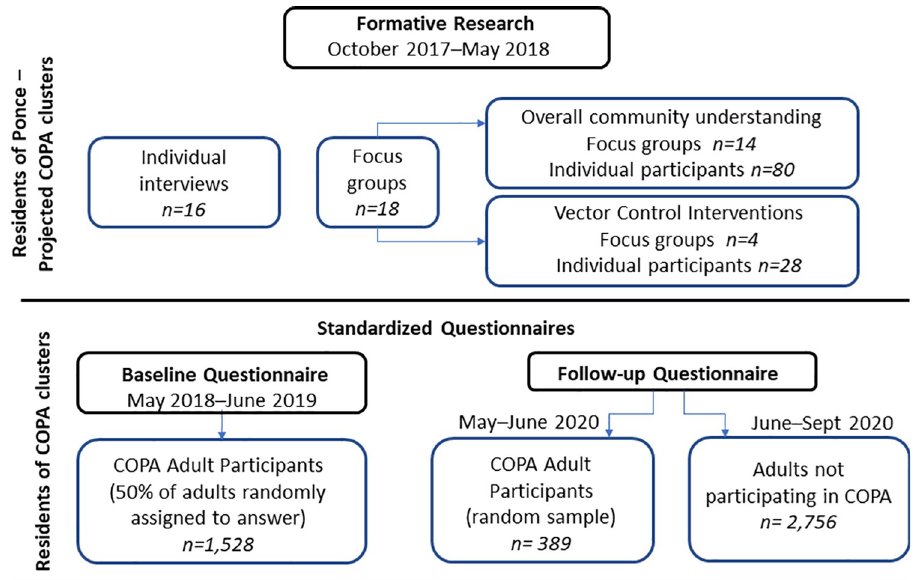
Fig 1. Summary of data sources for assessment of community acceptability of Wolbachia suppression method, Ponce, Puerto Rico, 2017–2020.